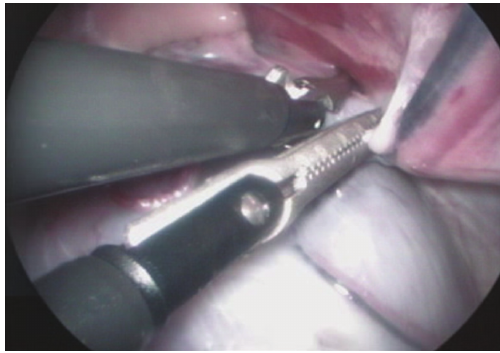
Figure 3: Careful retraction of the cryptorchid testicle from the internal inguinal ring with 5 mm diameter 43 cm length atraumatic forceps.